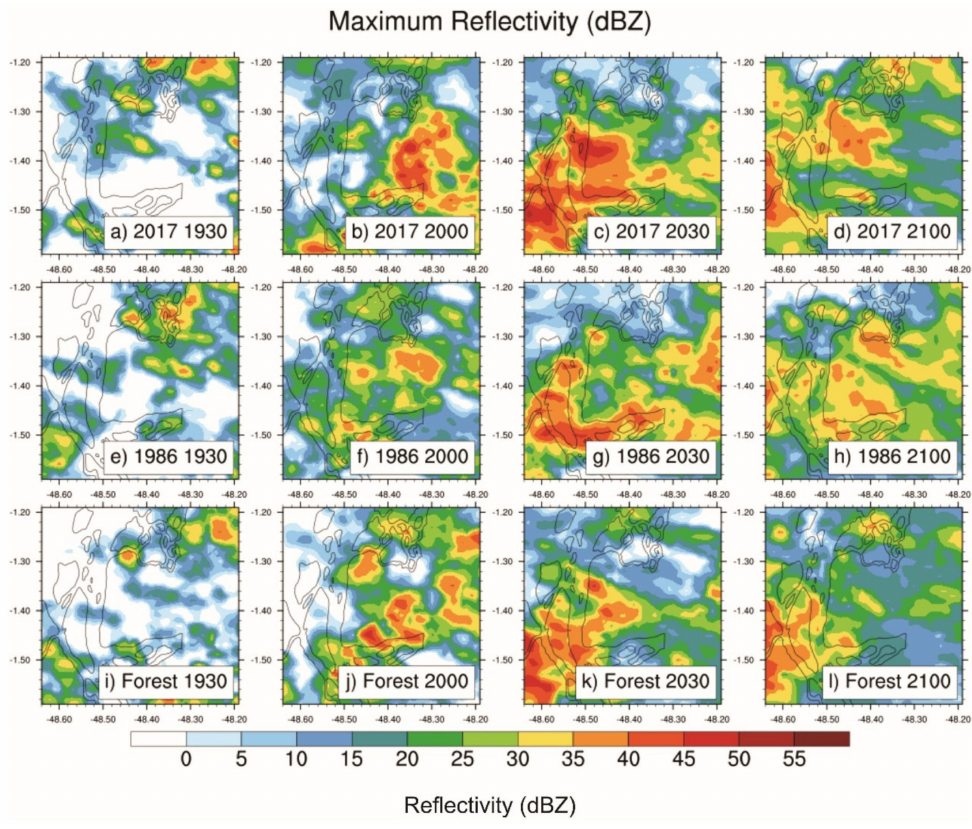
Figure 9. Maximum reflectivities (dBZ) for the 2017 ( a – d ), 1986 ( e – h ), and forest ( i – l ) scenarios at 1930, 2000, 2030, and 2100